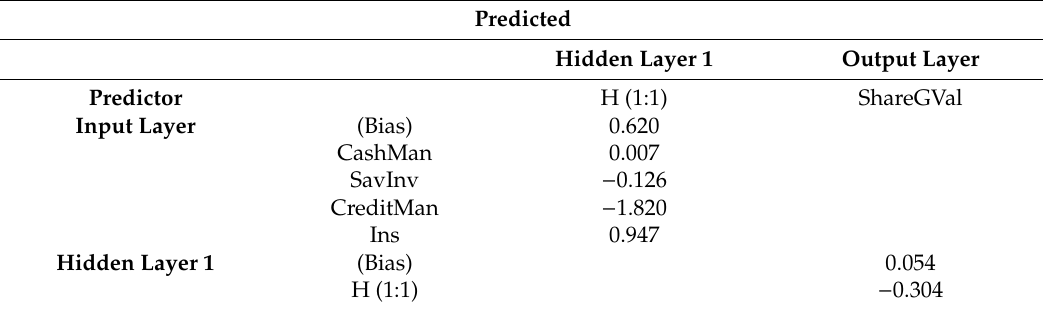
Table 8. Parameter estimates for Model D (calculated by the authors).